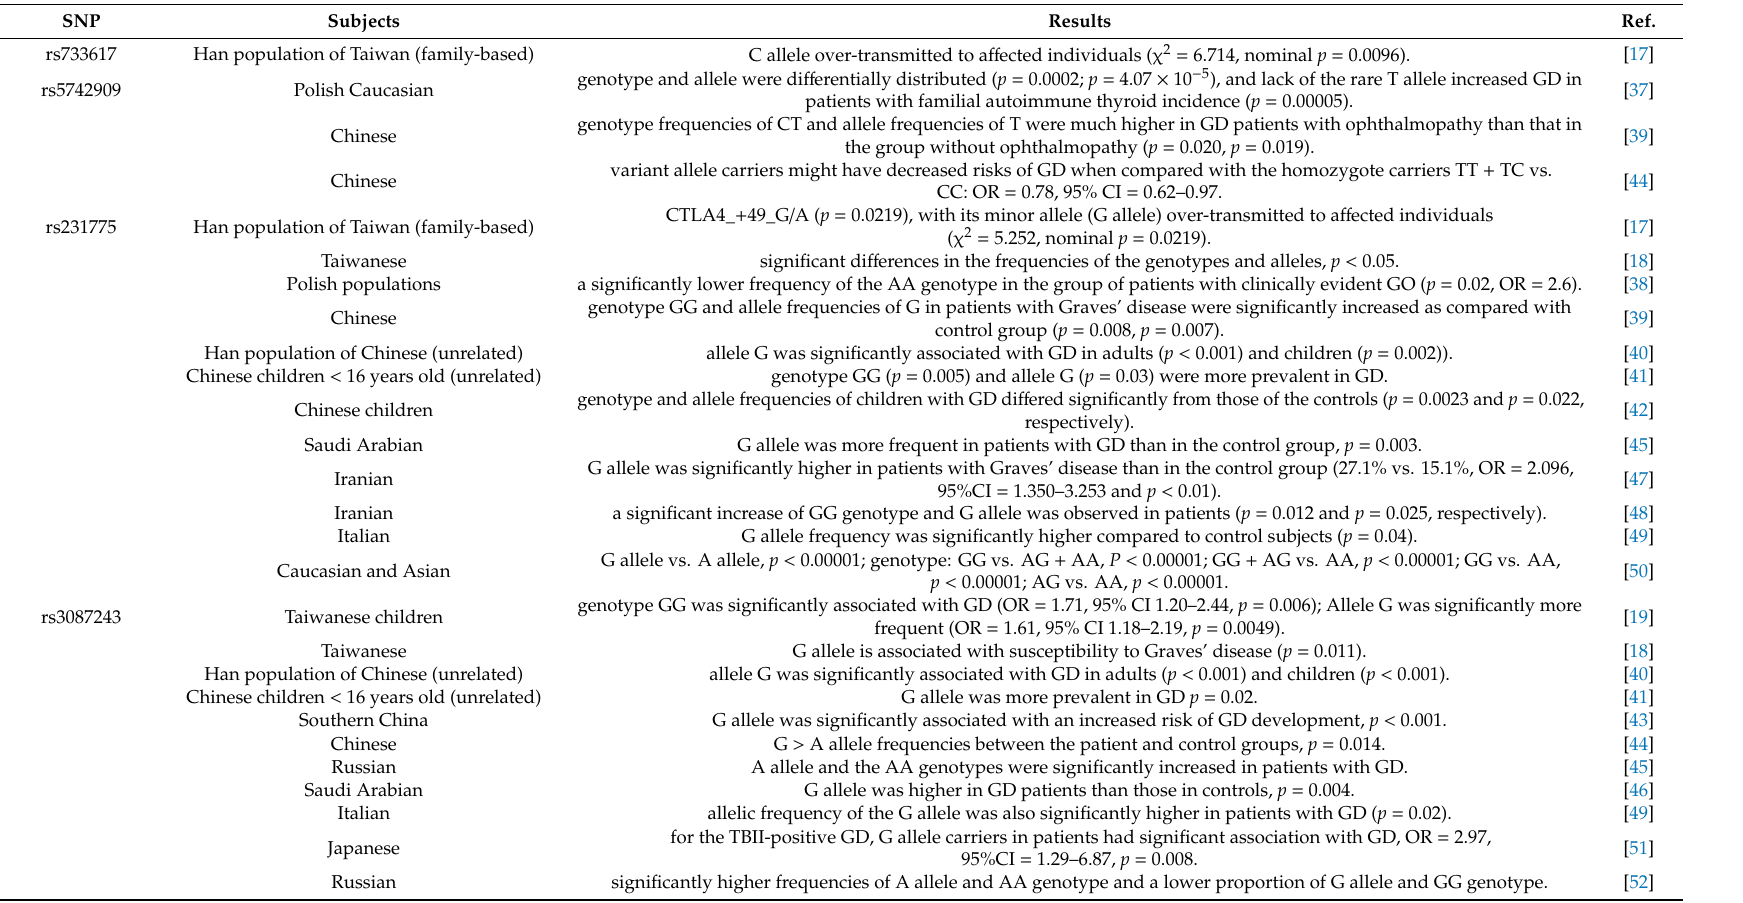
Table 7. Summary of several studies for CTLA4 SNPs associated with Graves’